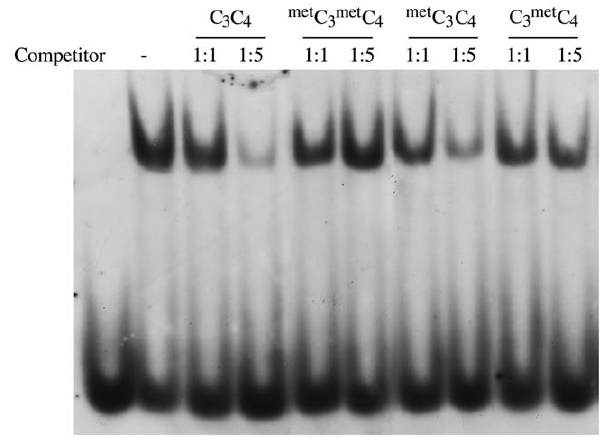
Figure 7. Methylation on CpG dinucleotides at putative transcription factor binding sites changes the affinity of protein complexes for the vav 1 regulatory region. (A) EMSA was performed with Jurkat T cell nuclear extracts and lil3-4 labeled oligonucleotide. The probe was created by annealing complementary oligonucleotides lil79 and lil80 (Table 3).-3 9 ). The following unlabeled competitors were added: unmethylated lil79-80 oligonucleotide (C 3 C 4 ); oligo methylated on both CpG methylation sites ( met C 3met C 4 ); oligo methylated only on CpG 3 ( met C 3 C 4 ), or only on CpG 4 (C 3met C 4 ). Competitor oligonucleotide was added in an amount equal to the labeled oligo (1:1) or in 5 molar excess (1:5).